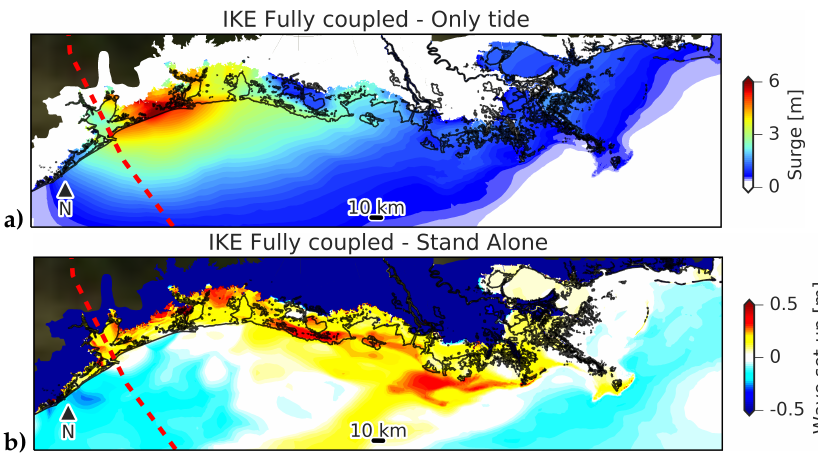
Figure 3. Total surge level computed by subtracting the tide only run from the Fully coupled case which includes both atmospheric and wave coupling contributions ( a ). The maximum wave contribution in total water level computed by subtracting the Stand alone case from Fully coupled ( b ). Red line represents Hurricane Ike’s best track. Black contour line represents the shoreline, and the areas beyond the black contour lines are the inundated regions. All model configurations and results are pre-decisional and for official use